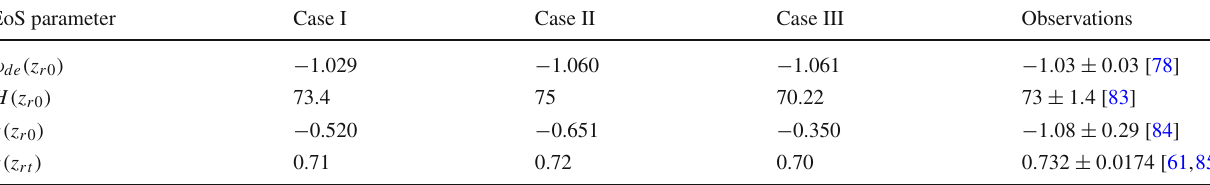
Table 4 Table for present values of cosmological